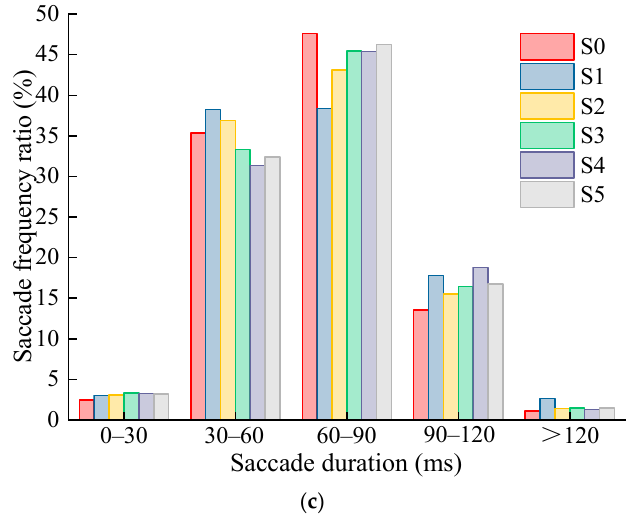
Figure 6. Distribution of driver’s saccade durations at different TSIV of the three-speed conditions. ( a ) 60 km/h; ( b ) 80 km/h; ( c ) 100 km/h.